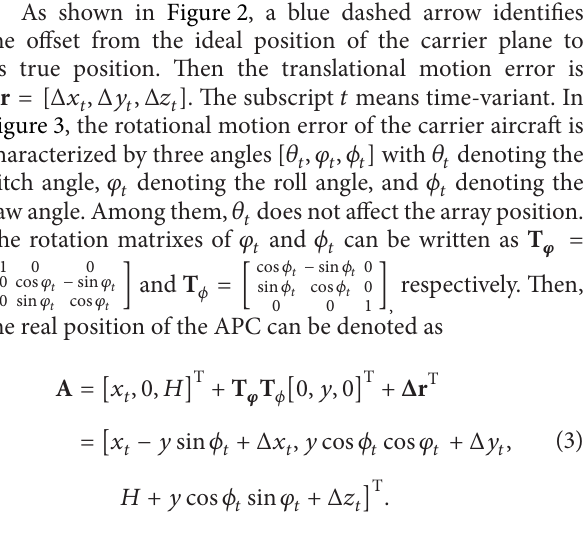
this method as single-channel MOCO (SC-MOCO)